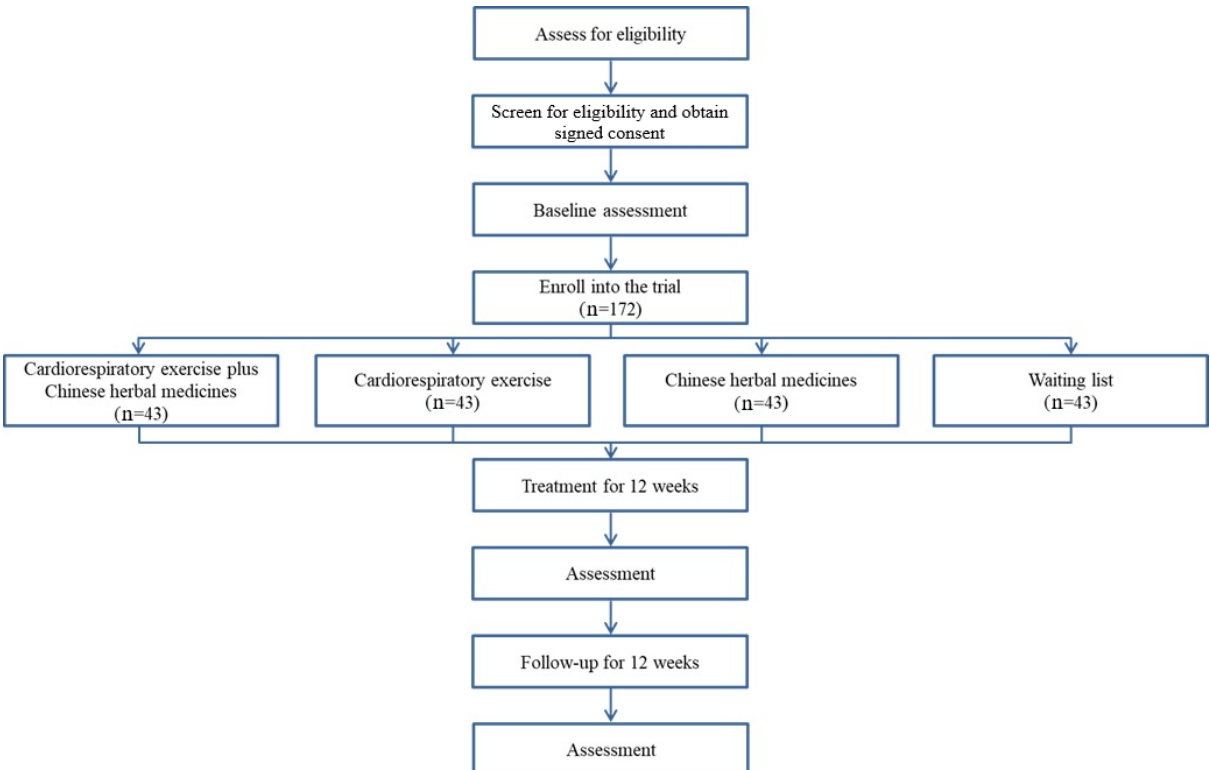
Figure 1. Flow diagram of the